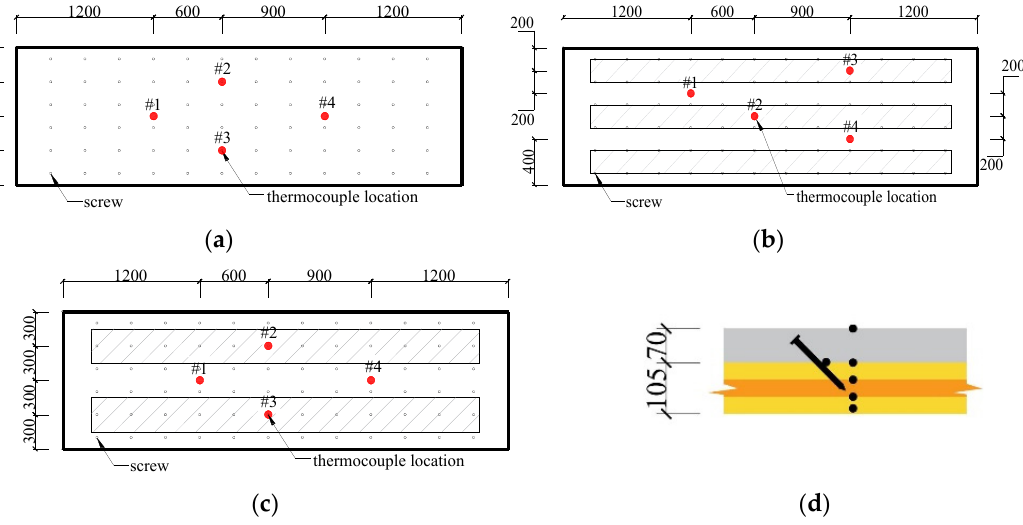
Figure 5. Location of the thermocouples: ( a ) TCC1; ( b ) TCG2; ( c ) TCG3; and ( d ) the depths of the thermocouples (units: mm).